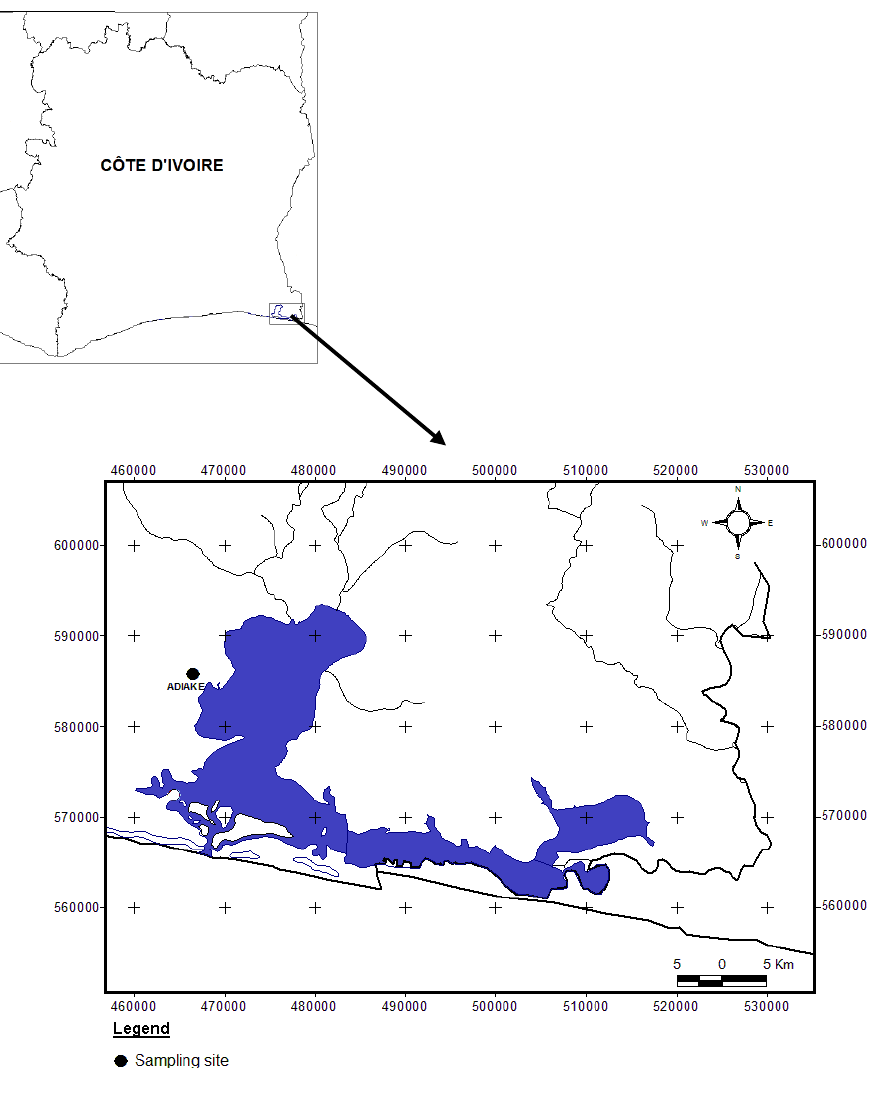
Figure 1. Map showing Aby lagoon and sampling